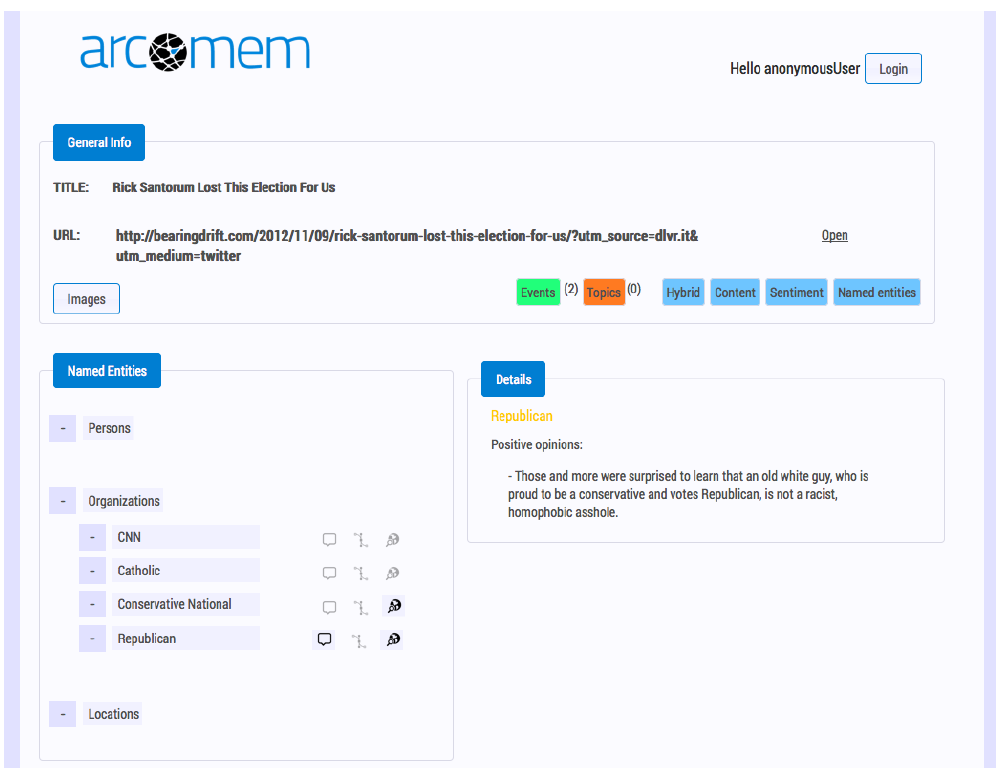
Figure 3. An individual web resource page in SARA.